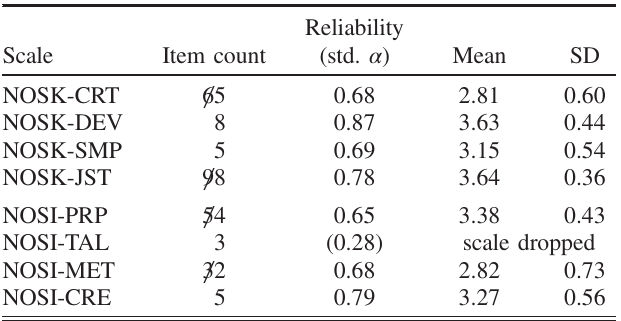
TABLE IV. Scale overview for the whole student sample. For each scale the item count and standardized Cronbach ’ s α is given. Item count is given indicating dropped items as well. For